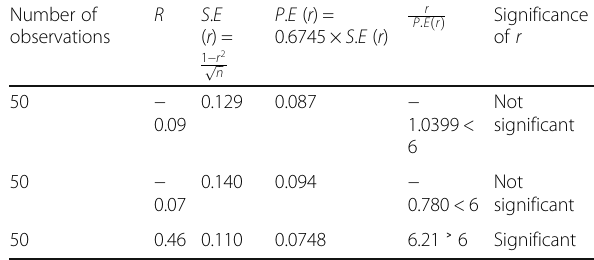
Table 2 Significance of correlation between Thumb, Index, and Ring finger per unit length for middle position Number of observations